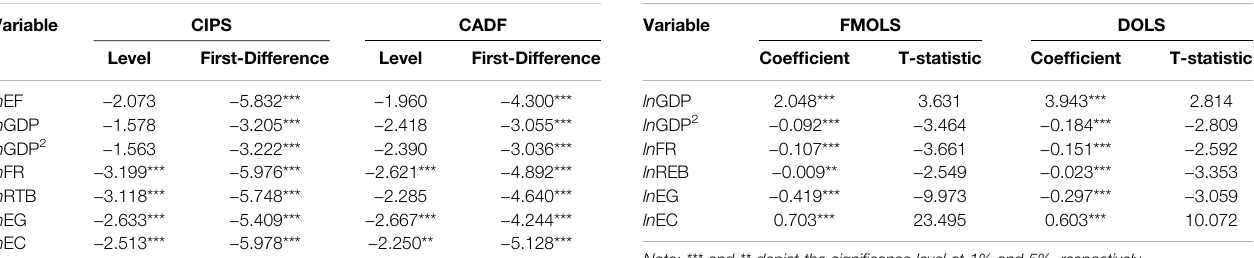
TABLE 5 | Unit root test results.